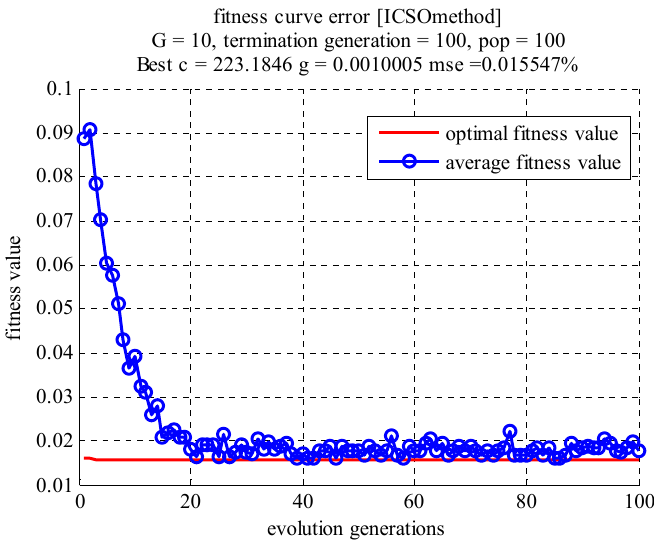
Figure 6. The fitness curve of improved chicken swarm optimization algorithm. Appl. Sci. 2019 , 9 , x FOR PEER REVIEW